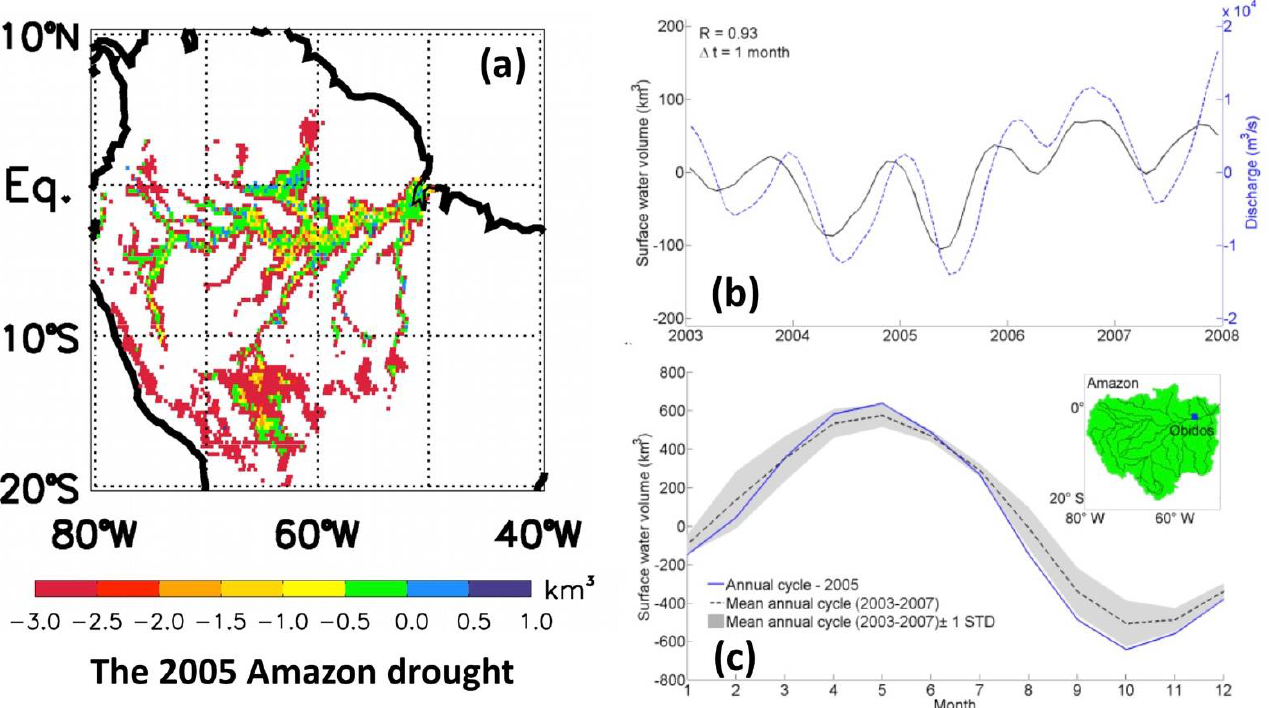
Figure 5. Surface water storage variations and extreme events: the 2005 Amazon drought. ( a ) Satellite-derived surface water storage anomalies during September–October 2005 (averaged and relative to the mean over 1993–2007), Reprinted with permission from [78] 2013 John Wiley and Sons. ( b ) Interannual variations of surface water storage over the Amazon River basin for 2003–2007 (black line) and discharge at Obidos (dotted blue). Reprinted with permission from [130] 2012 IOP Publushing ( c ) Annual cycle of surface water storage change in the Amazon for 2005 (blue) and average over 2003–2007 (dotted black) with standard deviation (gray area). Reprinted with permission from [130] 2012 IOP Publushing.